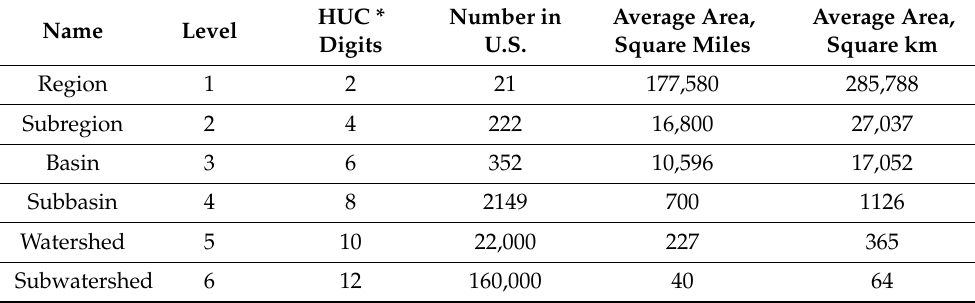
Table 1. Classification of watersheds and river